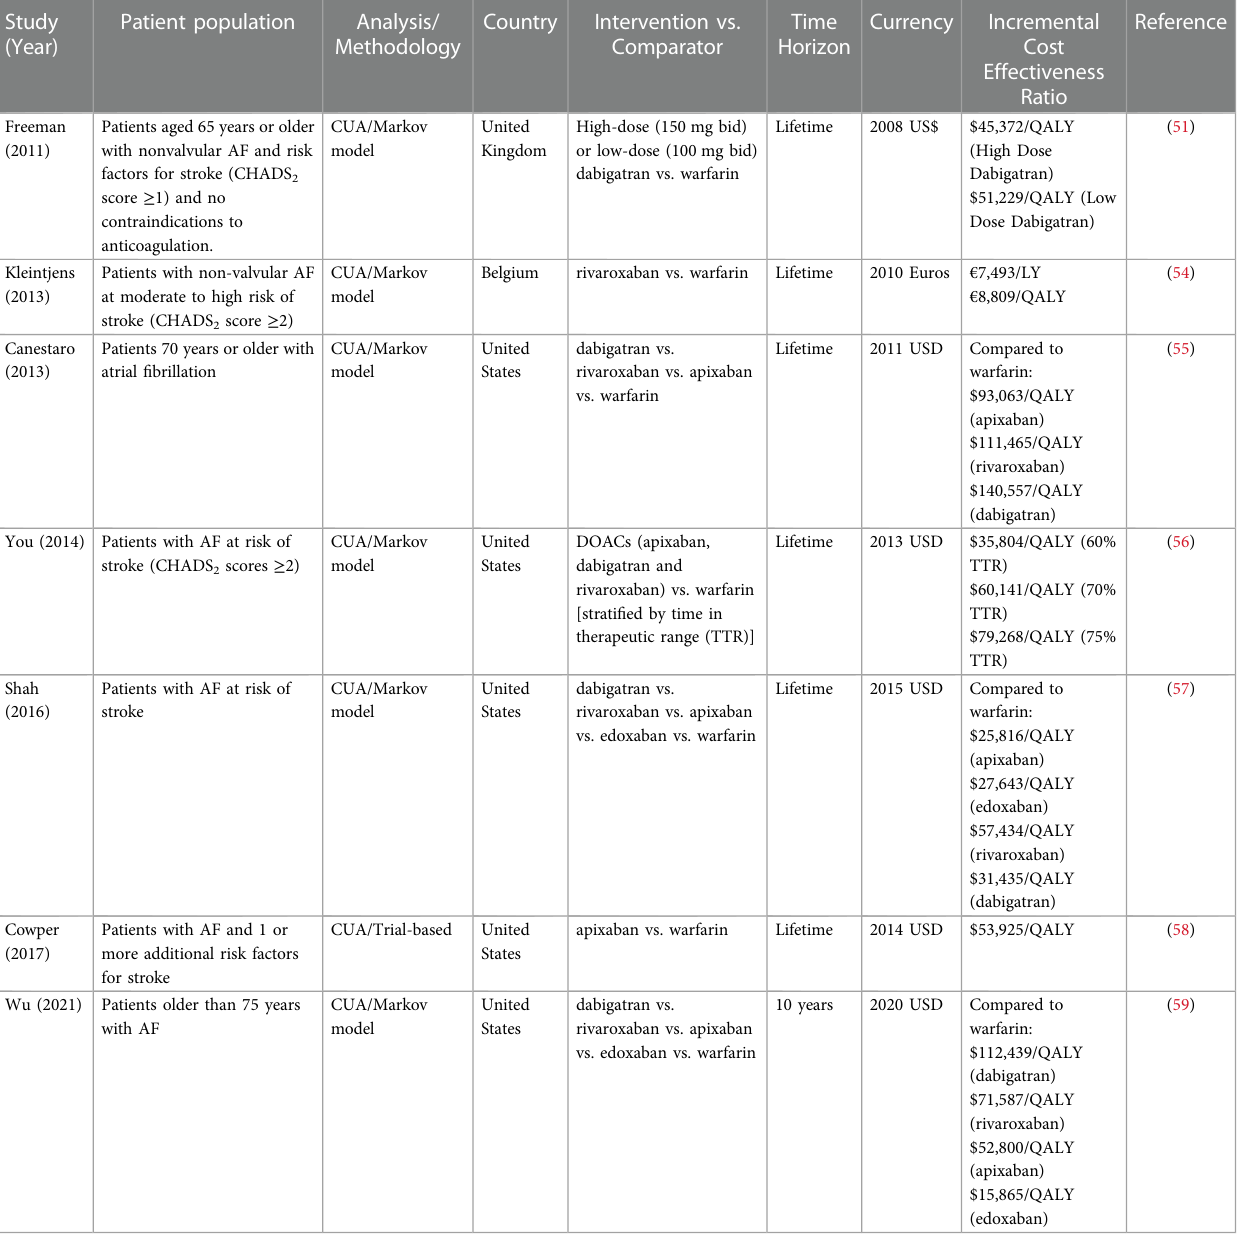
Freeman Patients aged 65 years or older (2011) with nonvalvular AF and risk factors for stroke (CHADS 2 score ≥ 1) and no contraindications to